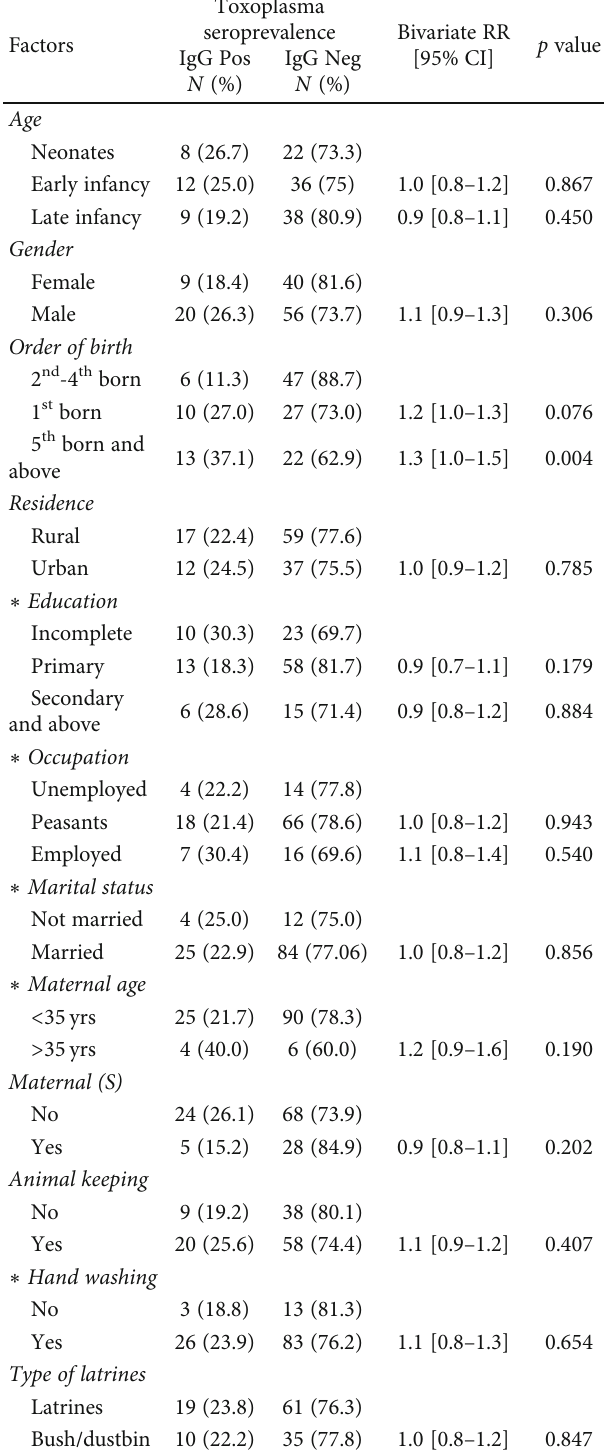
Table 2: Clinical characteristics of 125 infants with hydrocephalus. Table 3: Sociodemographic characteristic risk factors associated with T. gondii seropositivity among 125 enrolled infants and their